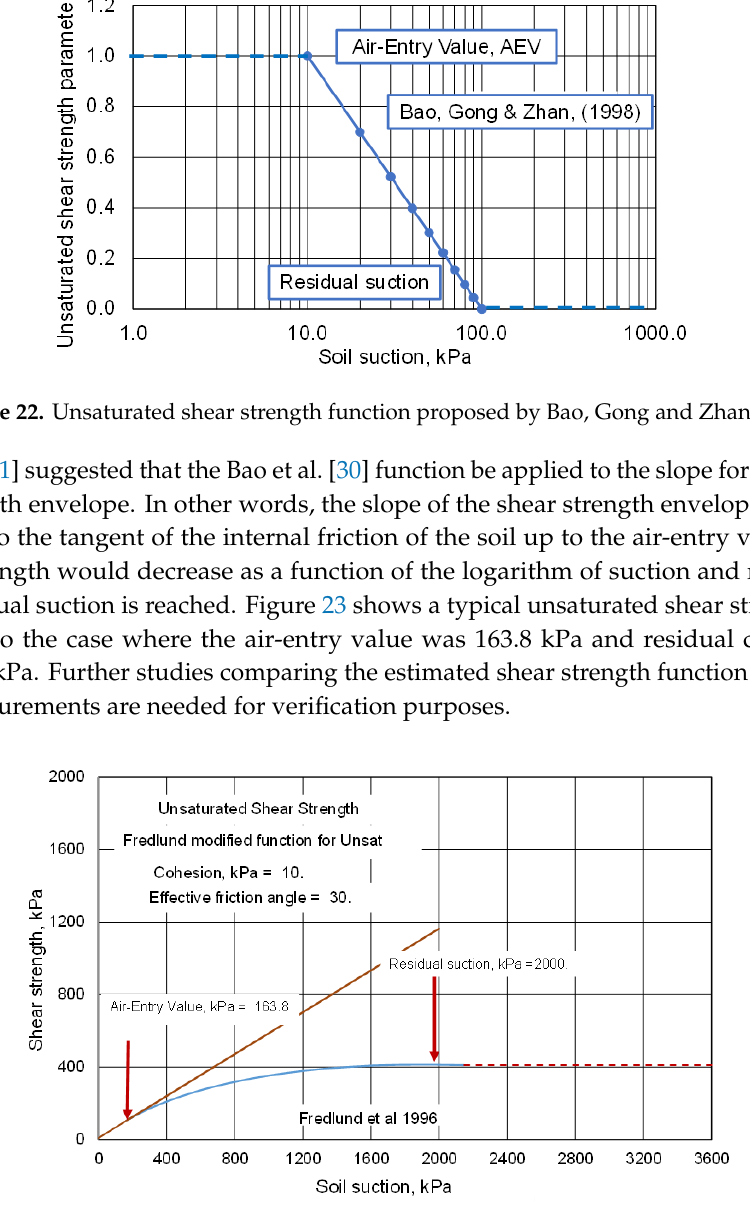
Figure 23. Proposed Fredlund [31] shear strength envelope for unsaturated soils.